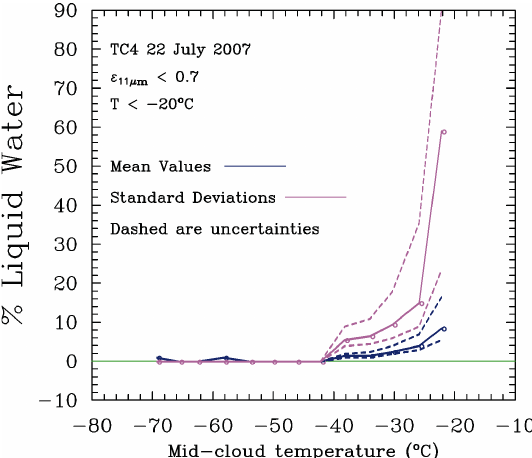
Fig. 9. Uncertainty estimates (dashed) for the means and standard deviations (solid) in Fig.